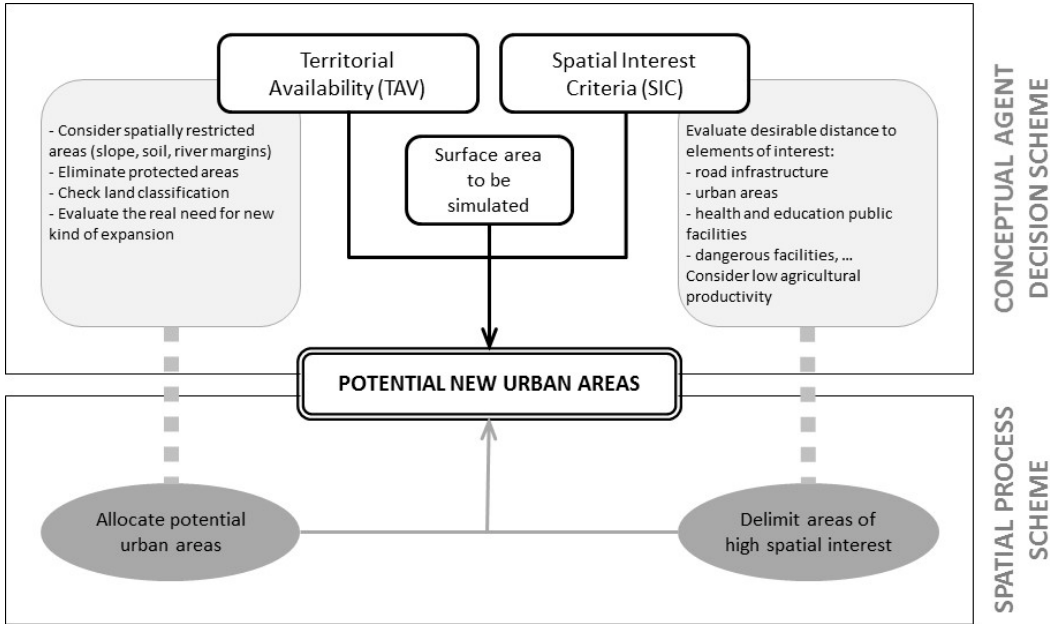
Figure 4. Conceptual decision structure of the urban planner submodel.